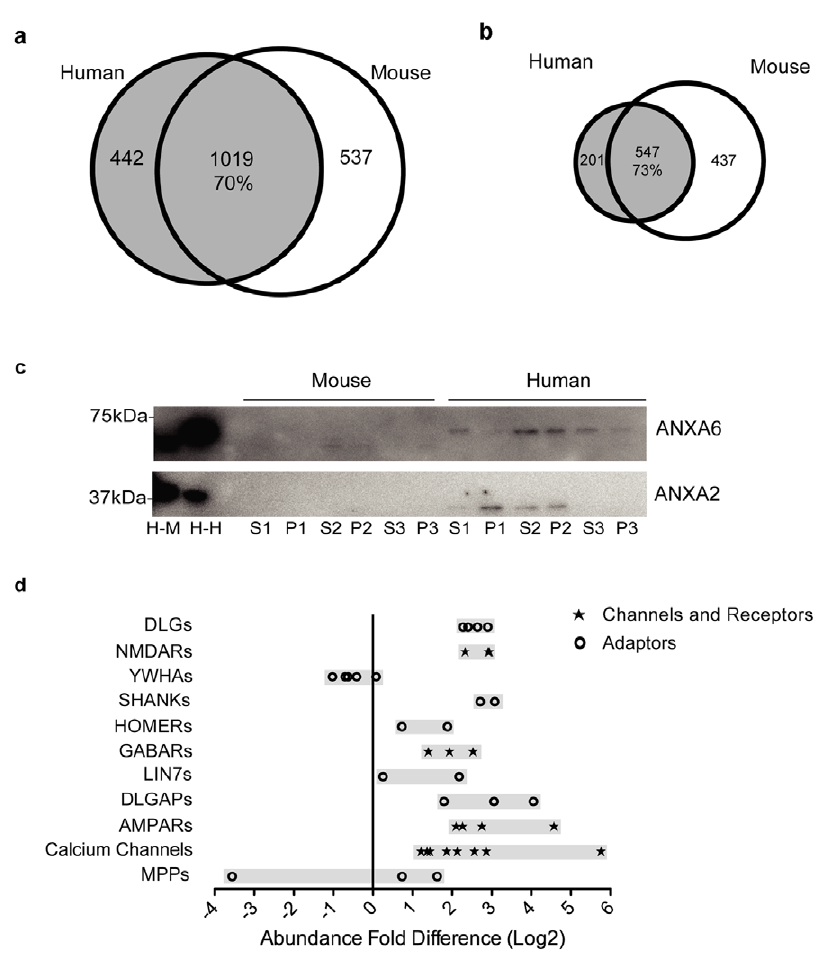
Figure 3. Inter-species differences on postsynaptic density proteins. a. Venn diagrams showing the total amount of proteins in mPSD and hPSD as well as the overlap between them relative to the hPSD. b. Venn diagrams showing the proteins identified in triplicate for the mPSD and hPSD, the overlap relative to hPSD between the two sets is also shown. c. Immunoblot validation of proteins identified only in the hPSD by mass spectrometry. The following samples were analyzed: H-M, mouse brain homogenate; H-H, human brain homogenate; and SX, each of the three synaptosomal fractions, PX, each of the three postsynaptic density fractions for both species. d. The abundance fold difference (AFD) between mouse and human is shown for members of adaptors, channels and neurotransmitter receptors protein families. AFD is calculated as the mouse to human ratio of normalized and log2 transformed average abundance values. For each protein family the number of proteins displayed is given in brackets.